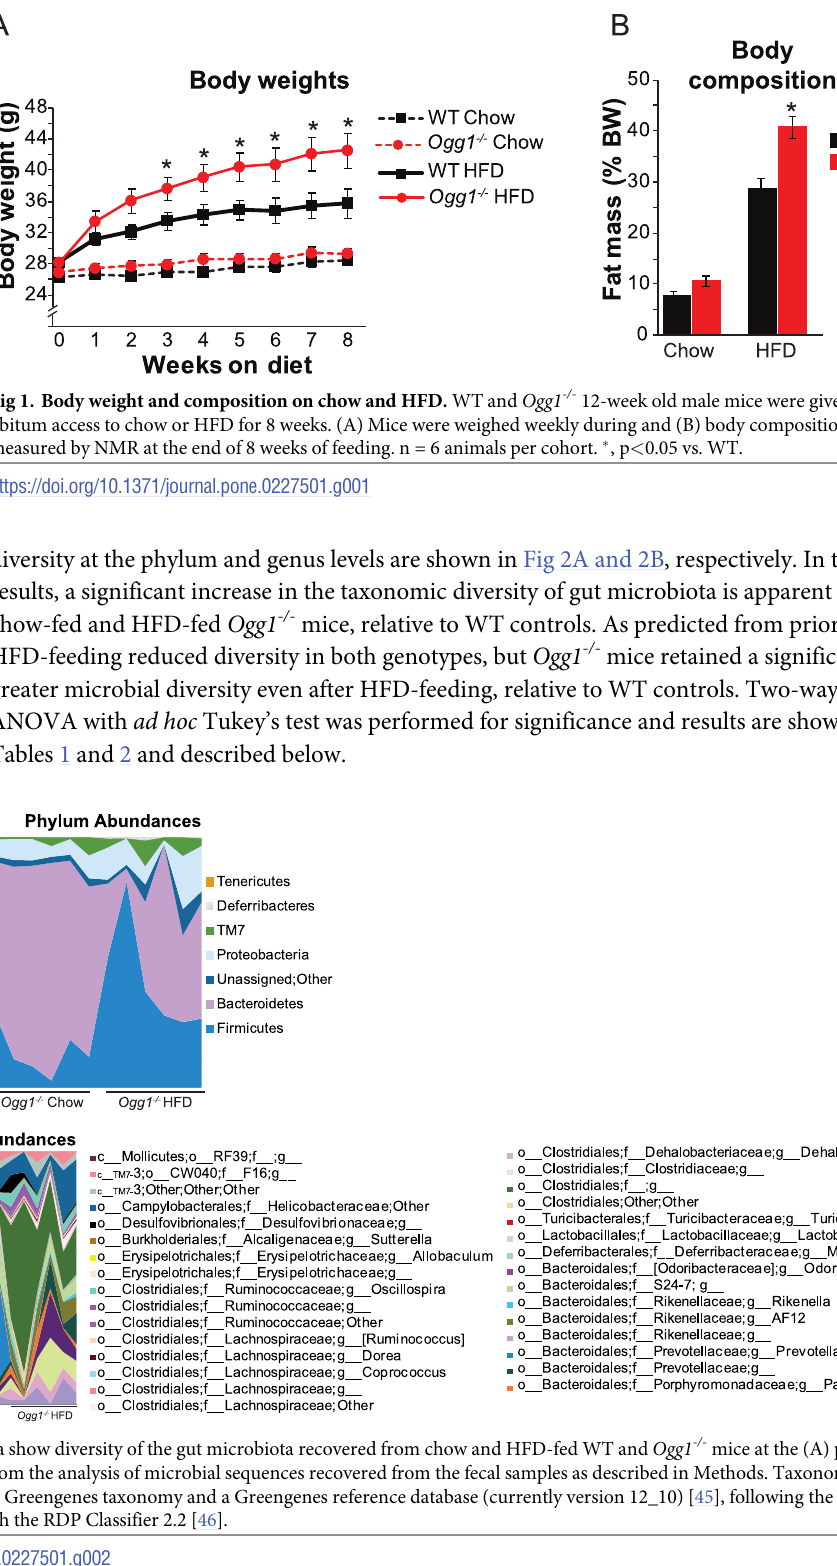
PLOS ONE | https://doi.org/10.1371/journal.pone.0227501 January 14,